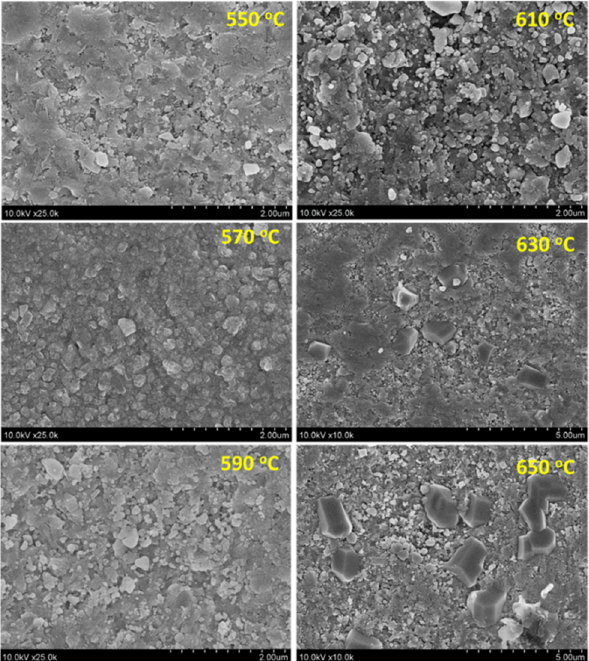
Figure 6. SEM micrographs of the PMN–PT films annealed in the temperature range of 550–650 °C. Table 2. Atomic composition of the as-deposited and annealed PMN–PT films.